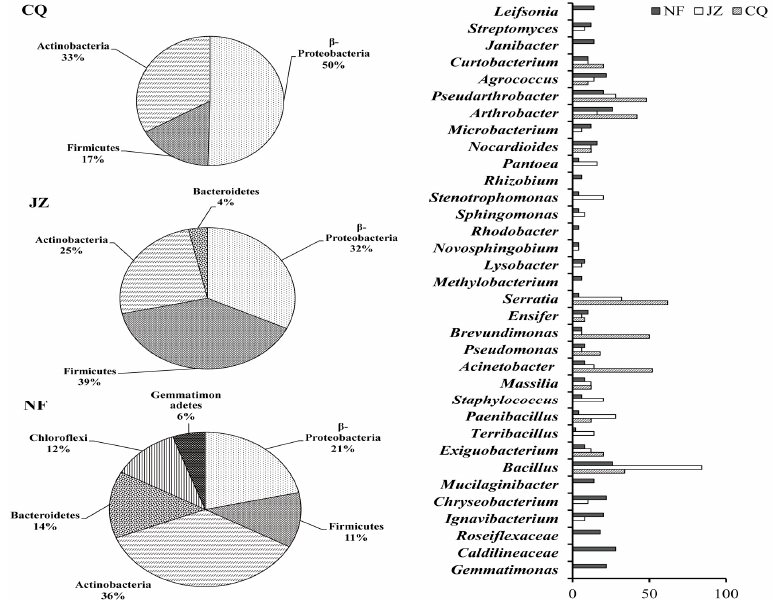
Figure 2. Differences of culturable bacteria in water spinach rhizosphere soil at the phylum and genus levels. CQ: farmland next to the company area; JZ: farmland near Jiazhuang village 3 km away from the company; NF: farmland near Nanfan village 6 km away from the company.